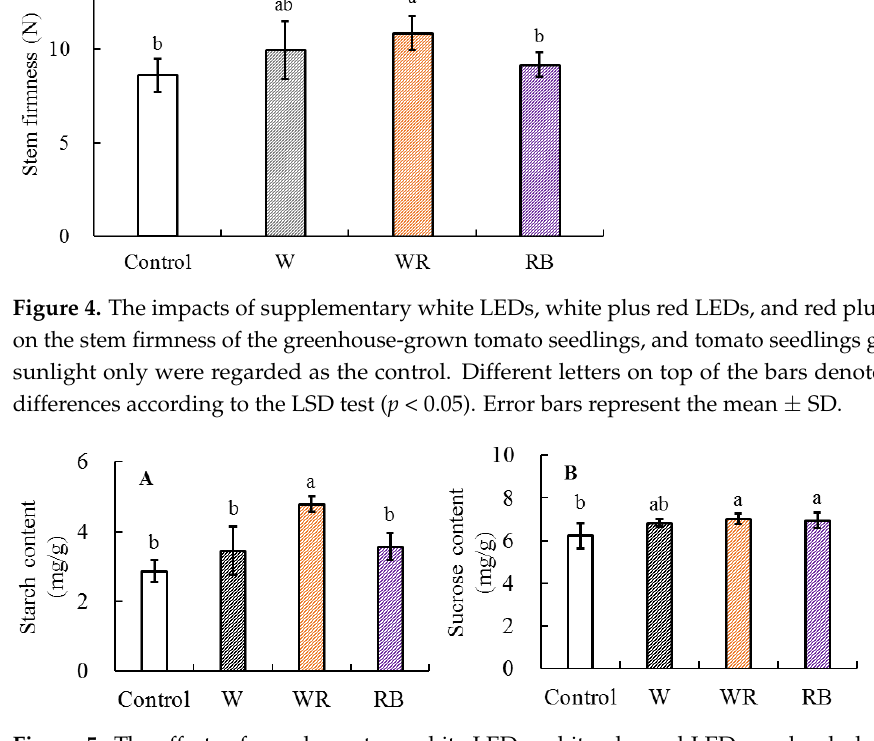
Figure 5. The effects of supplementary white LEDs, white plus red LEDs, and red plus blue LEDs on starch content ( A ), and sucrose content ( B ) of the greenhouse-grown tomato seedlings, and tomato seedlings grown under sunlight only were regarded as the control. Different letters on top of the bars denote significant differences according to the LSD test ( p < 0.05). Error bars represent the mean ± SD.